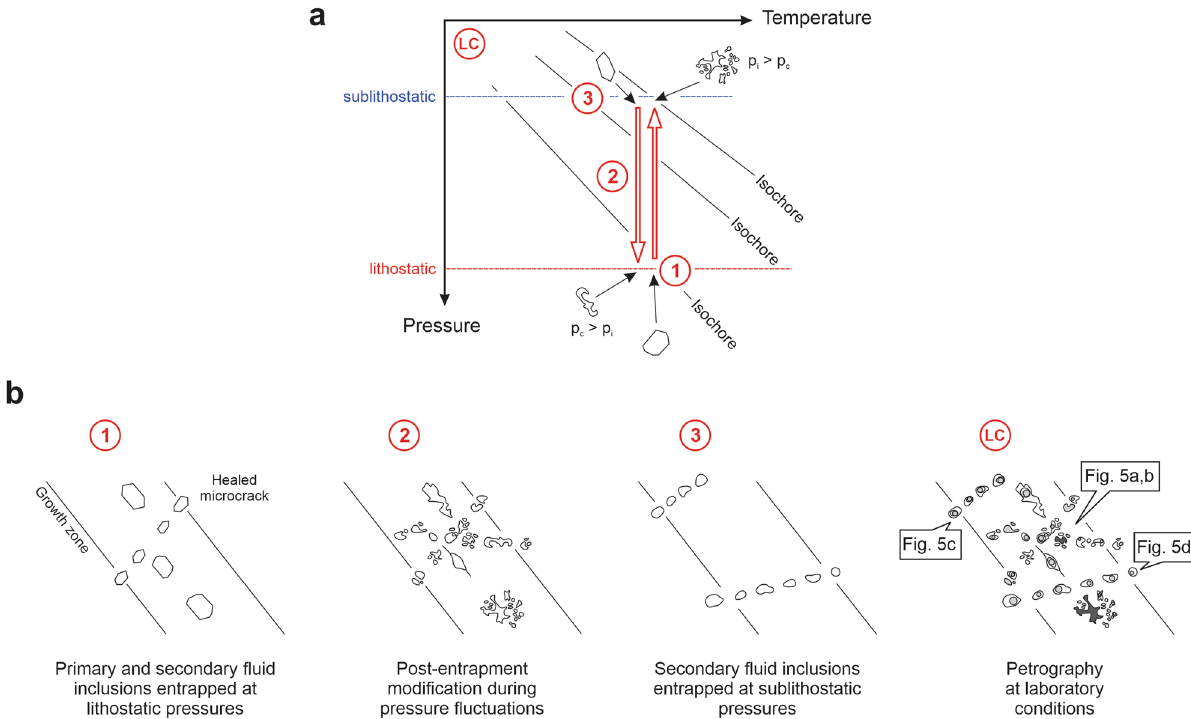
Figure 6. Diagram showing how the fluid inclusion petrography of vein quartz from the Garrcon deposit was formed in different pressure regimes. ( a ) Pressure–temperature diagram showing the conditions at which fluid inclusion assemblages in the veins are entrapped or observed. Early quartz contains primary and secondary fluid inclusions entrapped at lithostatic conditions (1). Post-entrapment modification of the fluid inclusions occurs during pressure fluctuations between lithostatic and sublithostatic conditions (2), as the fluid inclusions are not strong enough to withstand the pressure differentials from entrapment followed by a pressure drop (internal pressure > confining pressure) or entrapment followed by pressure increases (confining pressure > internal pressure). Secondary fluid inclusion assemblages are entrapped at hydrostatic conditions (3). Study of the fluid inclusion petrography occurs at laboratory conditions (LC). ( b ) Petrographic characteristics of fluid inclusion assemblages entrapped at the different pressure and temperature conditions. Early quartz may contain primary fluid inclusions along growth zones and secondary fluid inclusions along healed microcracks (1). The early formed fluid inclusions are affected by post-entrapment modification during pressure fluctuations (2). New secondary fluid inclusion assemblages are also formed at this stage and modified during subsequent pressure changes. Late secondary fluid inclusions are entrapped at sublithostatic pressures (3). At laboratory conditions (LC), a complicated integrated history of different fluid inclusion assemblages formed at different pressure and temperature conditions through time can be observed. Inclusions rich in CO 2 can display double bubbles at room temperature, whereas H 2 O-dominant fluid inclusions may consist of a liquid and vapor phase only. Fluid inclusion assemblages that show consistent volumetric proportions among the various phases within individual inclusions must have been entrapped at sublithostatic pressures and never have been subjected to lithostatic conditions. LC laboratory conditions, p c confining pressure, p i internal potentially entrapped at near-hydrostatic pressures and subsequently modified during pressure build-up to lithostatic conditions (Fig. 6), suggestive of pressure cycling. Due to the post-entrapment modification of the fluid inclusions 14,41,42 , fluid inclusion microthermometry cannot be used to determine the pressure and tempera- ture conditions 41,42 of formation of the elongate and blocky quartz in the extensional veins at Garrcon, or the subsequent fluid-mediated recrystallization. Based on the vein petrography and fluid inclusion petrographic evidence, the occurrence of abundant pyrite and minor arsenopyrite in ribbons cutting the earlier elongate and blocky quartz and the presence of microscopic gold in the pyrite must thus be linked to cyclic variations in the pressure regime. During pressure build-up, hydro- thermal fluids are injected into the wall-rock surrounding fluid conduits. Sulfide formation occurs around the veins due to wall-rock sulfidation, resulting in a decrease in the amount of reduced sulfur in solution 2,4 . Sulfide deposition within the veins takes place as hydrothermal fluids that have reacted with the wall-rock are driven back into the vein during reversal in hydraulic head associated with the opening of the veins 37 . Gold transported by sulfide complexes is deposited 2,4 together with the sulfide minerals formed through wall-rock sulfidation in the wall rocks and within the veins. Gold forms microscopic inclusions in pyrite or occurs along microfractures cutting across pyrite grains formed during an earlier cycle of fluctuating pressures. The cyclic fluctuations in fluid pressure can be explained by temporary drainage of the geopressured fluids from the permeability barrier into the overlying near-hydrostatic realm (Fig. 7). Prior to failure, the fluid pressure